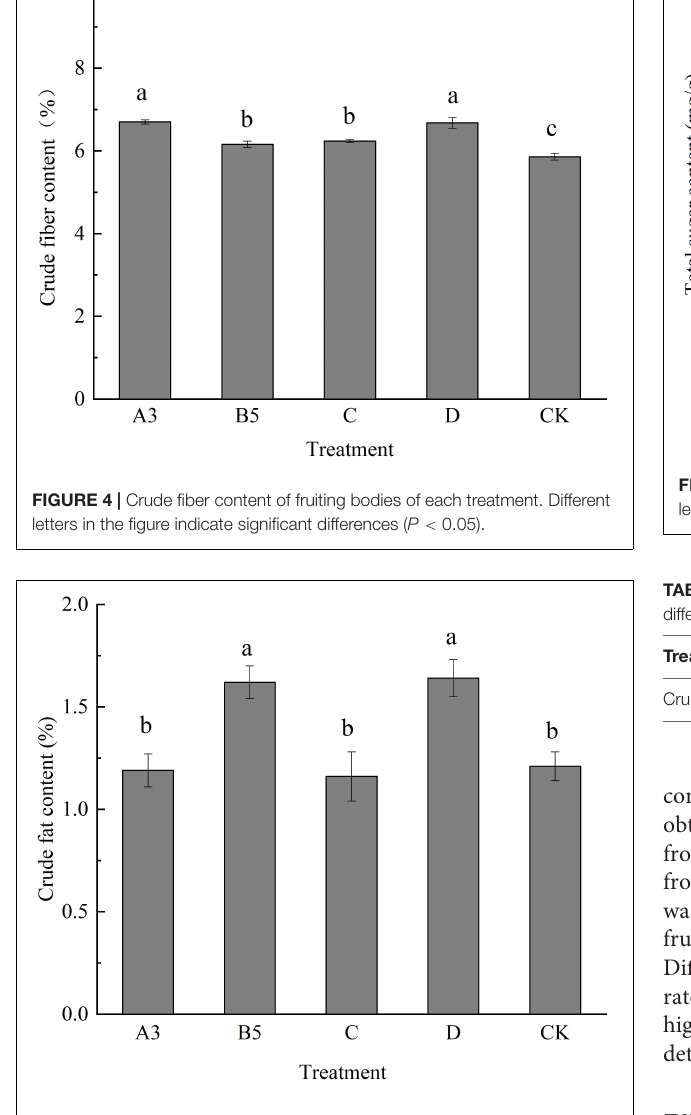
treatments were of great significance for supplementing human polysaccharides.